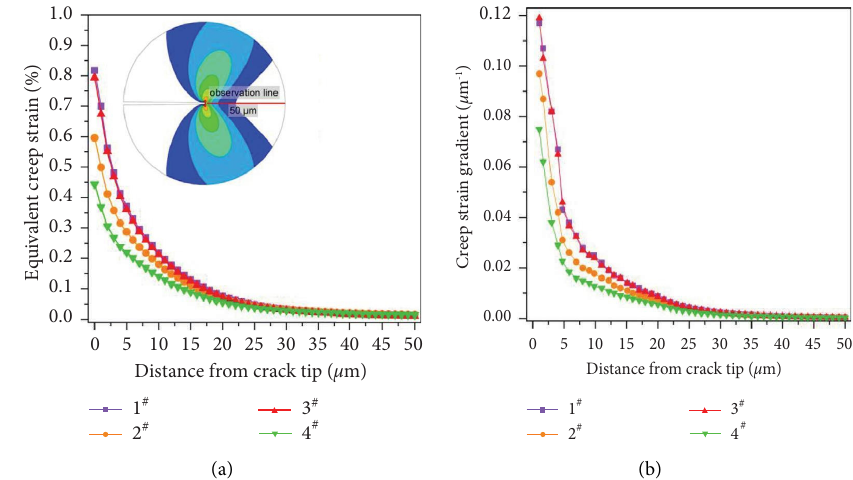
Figure 9: Equivalent creep strain on the observed line in front of the crack tip of Ti-6Al-4V alloy at diferent forging temperatures. (a) Equivalent creep strain. (b) Creep strain